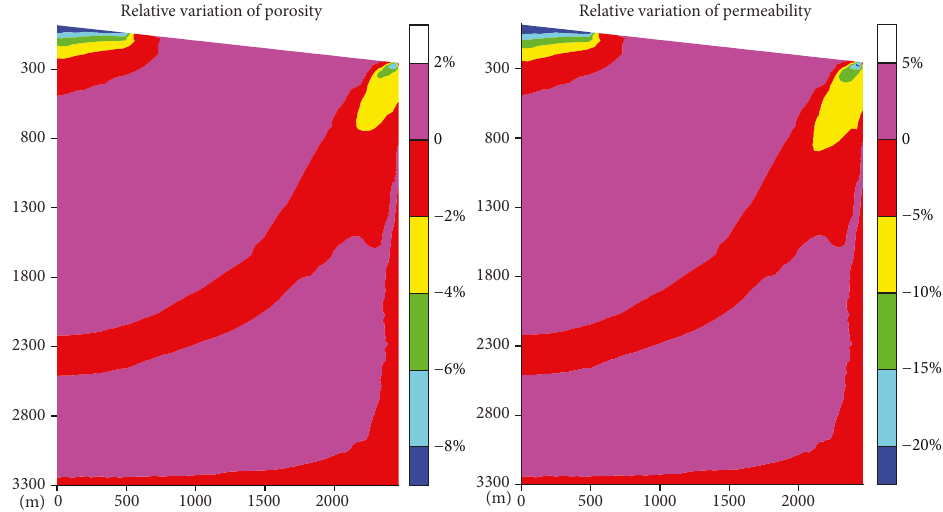
Figure 8: Relative variation of porosity and permeability within the fault F2 after 8000 years. Negative value means the decrease of porosity and permeability due to mineral